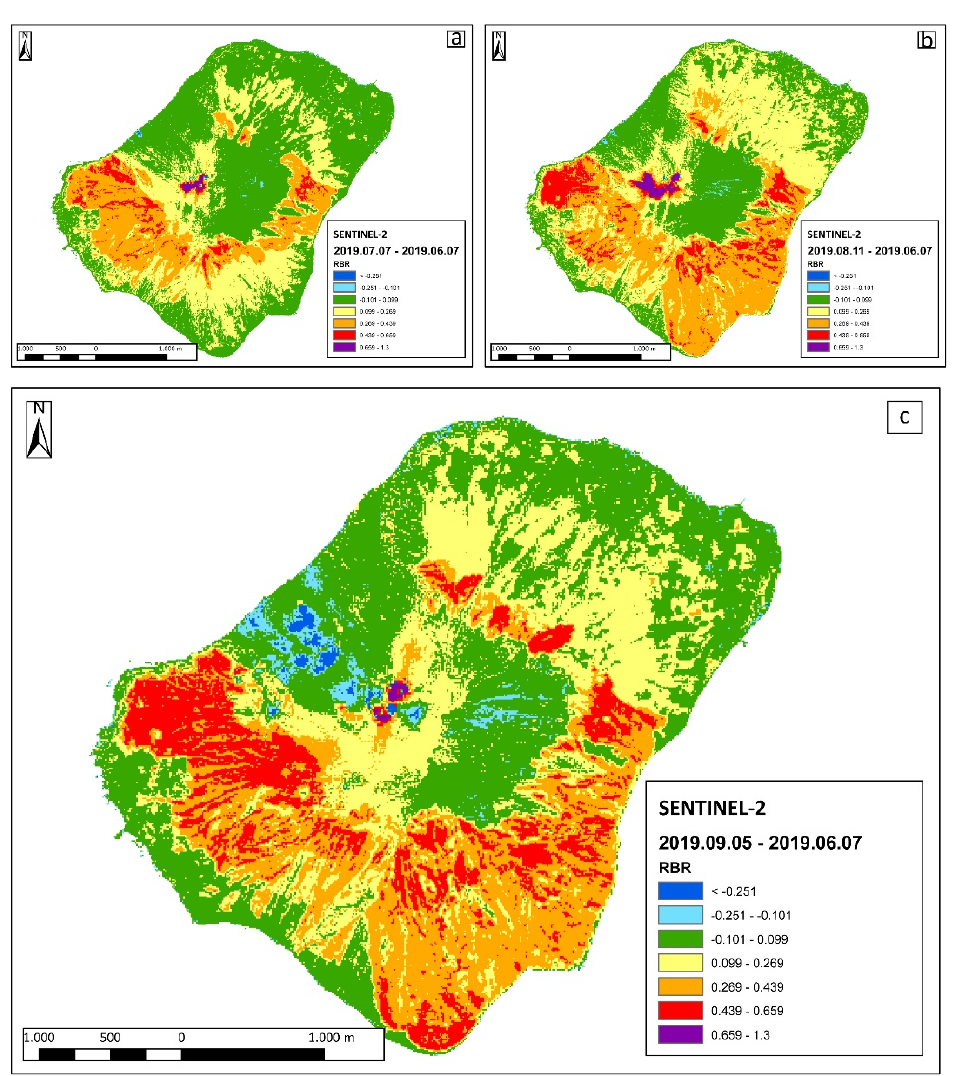
Figure 5. Sentinel ‐ 2 images ‐ derived Relativized Burn Ratio (RBR) on: ( a ) 7 th June 2019 – 7 th July 2019, Figure 5. Sentinel-2 images-derived Relativized Burn Ratio (RBR) on: ( a ) 7 June 2019–7 July 2019, ( b )